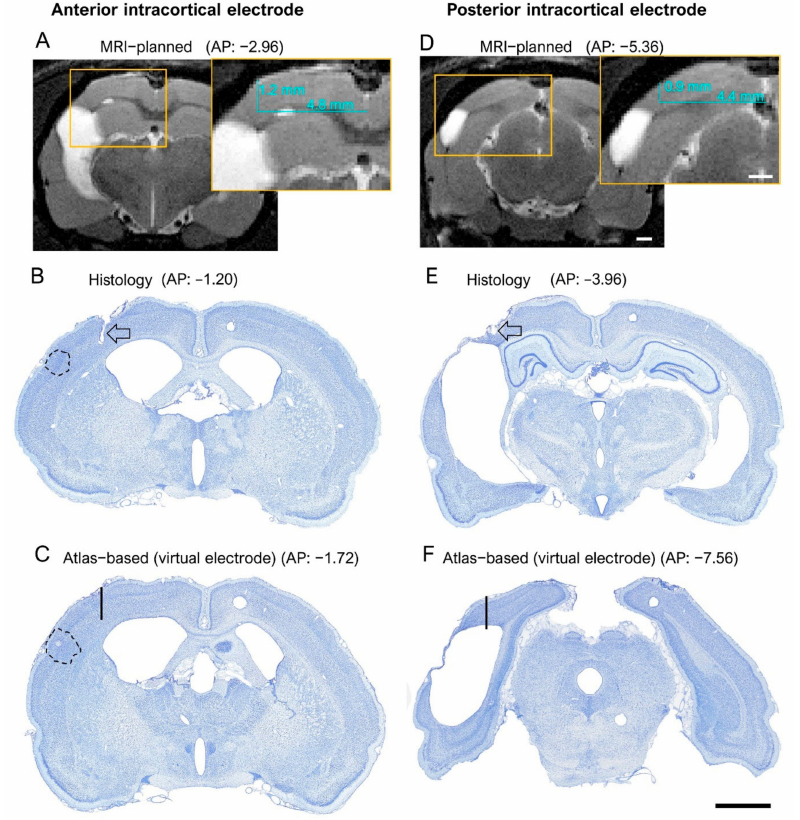
Figure 6. Histological confirmation of the success of MRI-guided electrode placement. Left panel ( A – C ): Anterior intracortical electrode MRI-planned coordinate, histological confirmation, and “vir- tual” electrode. Right panel: Posterior intracortical electrode MRI-panned coordinate histological confirmation, and “virtual” electrode. ( A ) T2-weighted MRI and ( B ) histological images showing the MRI-guided (insert) and histology-confirmed “true” location of the anterior intracortical electrode in rat 1139. The anteroposterior (AP) coordinate was estimated by aligning the magnetic resonance images with the rat brain atlas [25]. The mediolateral (ML) and dorsoventral (DV) coordinates (inserts in ( A , D )) were determined using ImageJ software (version 1.47v, Wayne Rasband and contributors, National Institute of Health, USA). Note that in this case, the confirmed AP location was about 1.8 mm more rostral than the planned location ( − 1.20 mm vs. − 2.96). Lesion area is denoted in black-dashed-line circle. ( C ) A “virtual” location of the electrode tip (black line) if the electrode had been implanted to the targeted atlas-based coordinate ( − 1.75 mm from bregma, 4 mm from midline, 1.8 mm from the surface of the brain). ( D ) MRI-guided (insert) AP, ML and DV coordinates and ( E ) histology-confirmed “true” location of the posterior intracortical electrode tip in rat 1139. The black-dashed-line circle denotes the lesion area. Note that the confirmed AP location was ap- proximately 1.4 mm more rostral than the planned location ( − 3.96 vs. − 5.36). Thus, even though both the anterior and posterior intracortical electrodes were more rostral than planned, their tips were recording EEG signals in the perilesional cortex. ( F ) A “virtual” electrode (black line) at the atlas-based coordinates would have ended up in the lesion cavity. Scale bar in ( A , D ) = 1 mm, and in ( B , C , E , F ) = 2